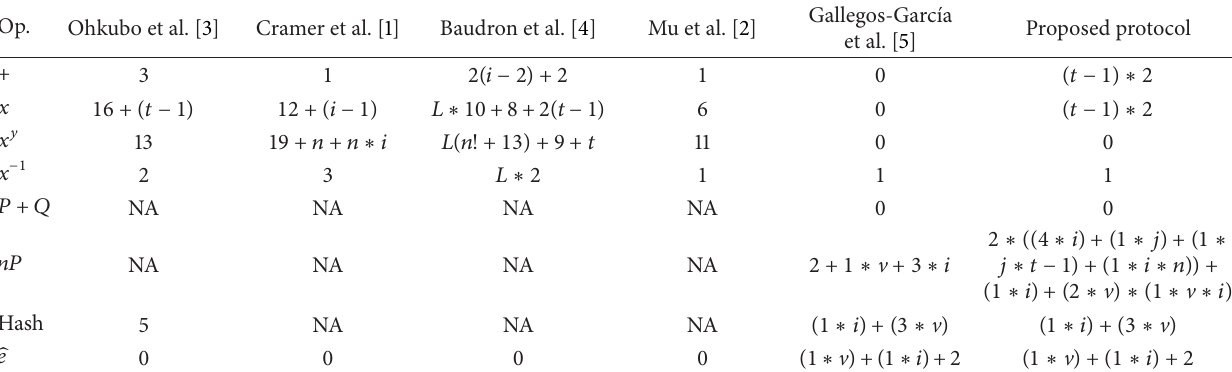
Table 2: Cryptographic operations developed in the proposed